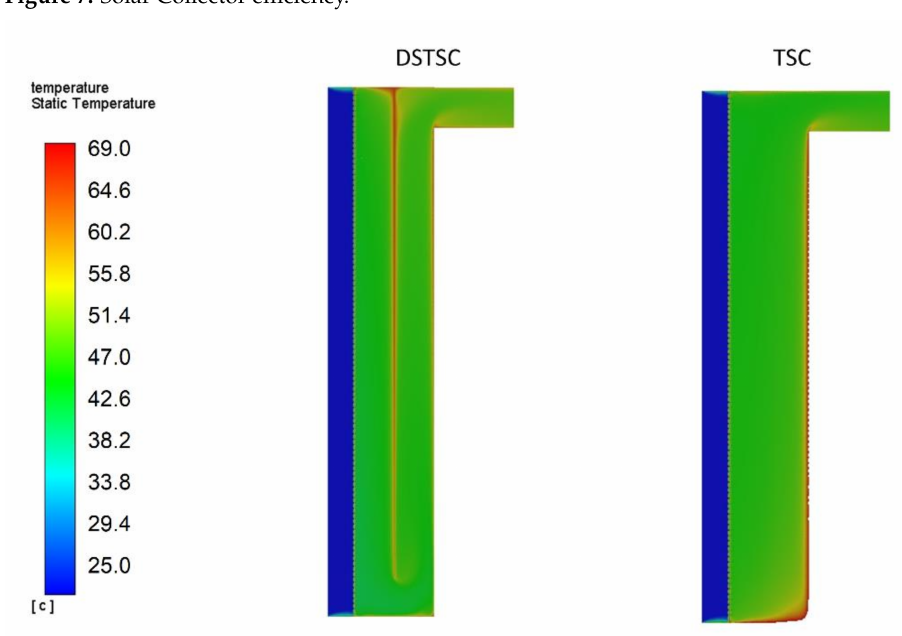
Figure 8. Temperature distribution in a median plane for the DSTSC ( left ) and TSC ( right ) at 100 m 3